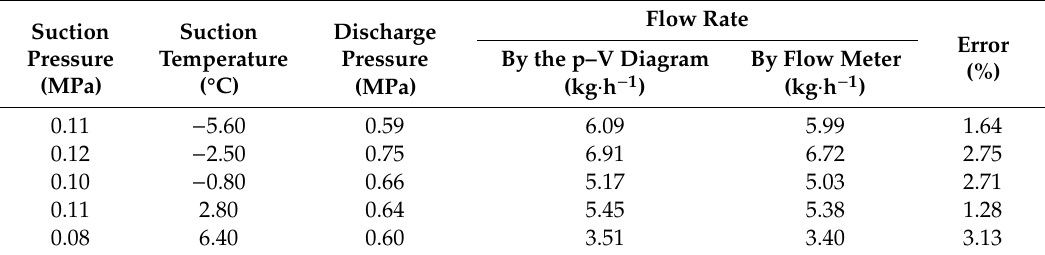
Table 3. The comparison of the experimental and calculated flow rate.